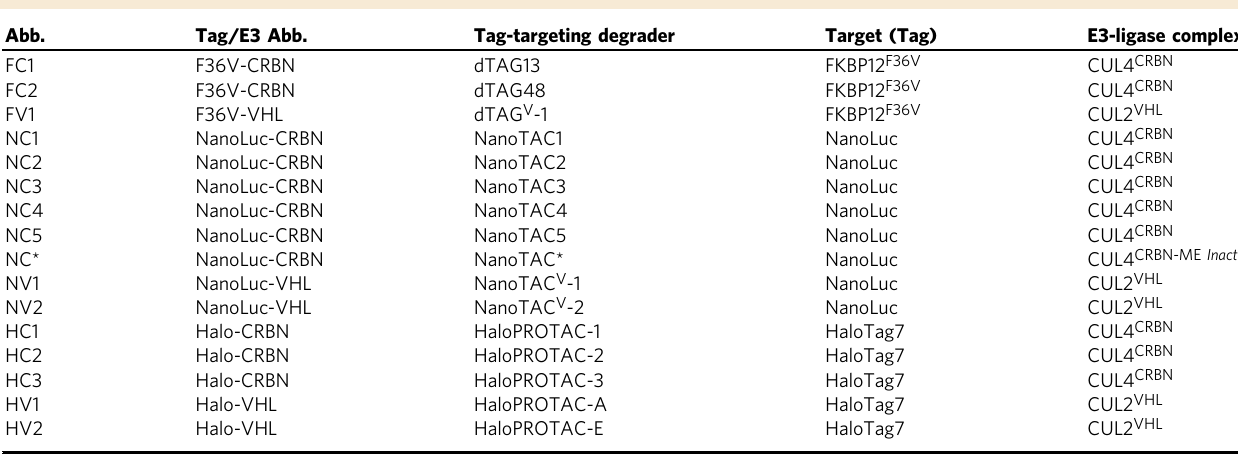
Table 1 tTPD system nomenclature.